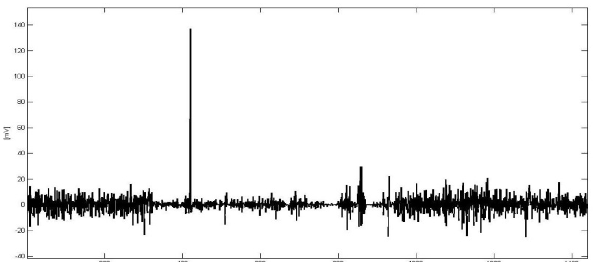
Figure 4. GFdiff prior to 6.6R EQ on January 6, 2008. 2 Fig. 4. GFdiff prior to 6.6R EQ on 6 January